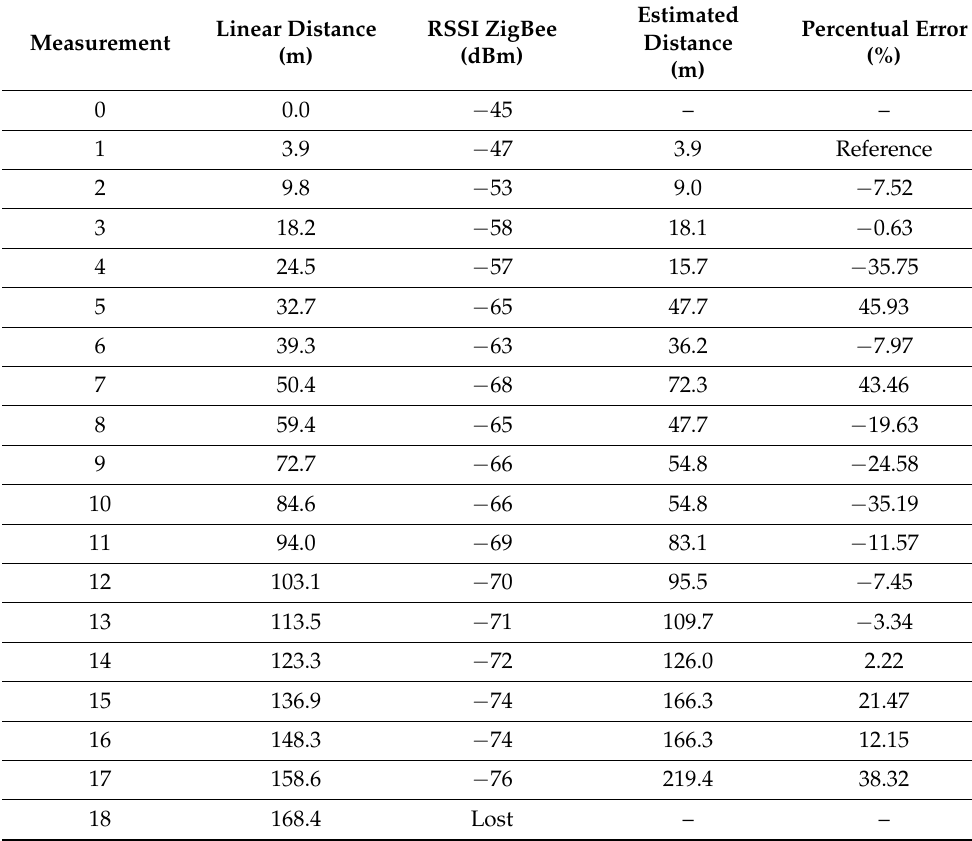
Table 3. Results of distance estimation obtained in the test for the wireless device.